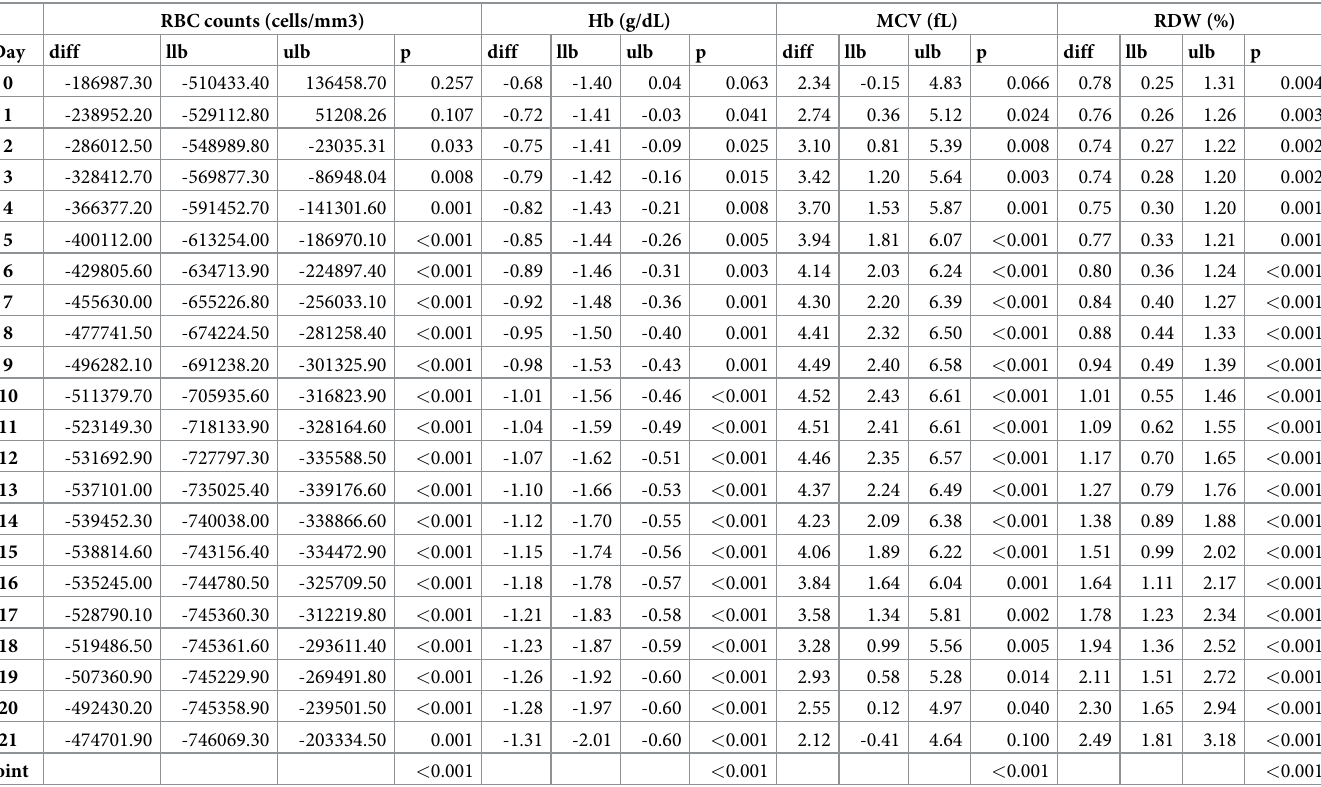
Table 3. Temporal evolution of the difference of red cell count, Haemoglobin level, MCV and RDW between survivors and non-survivors (diff). RBC counts